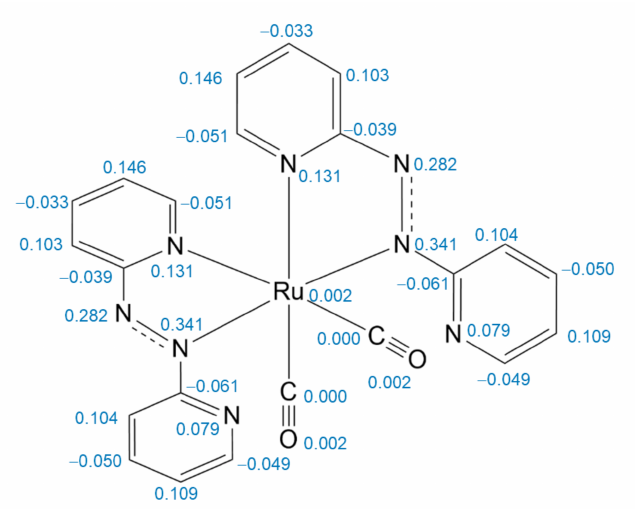
Figure 2. Spin density analyses for [Ru(apy · − ) 2 (CO) 2 ], calculated at the DFT/B3LYP/LanL2DZ/6- 31G(d) level of